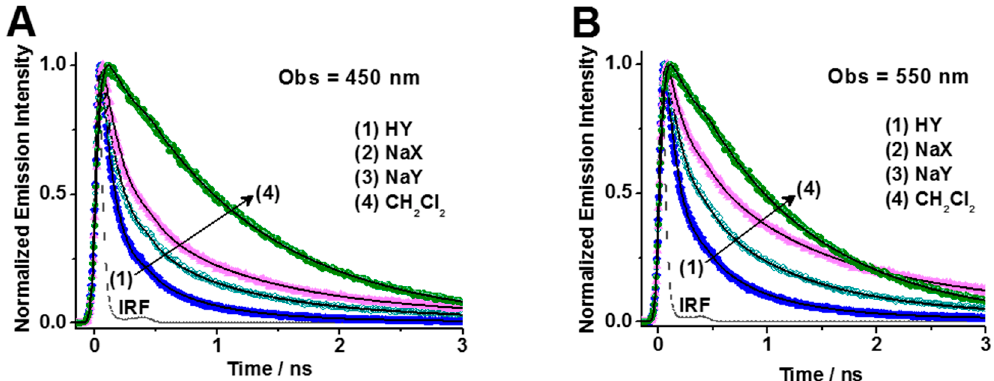
Figure 5. Normalized (to the maximum of intensity) magic-angle emission decays of DCM in presence of HY, NaX, and NaY zeolites (initial dye concentration: 1 × 10 − 4 M) in dichloromethane suspensions and comparison with the free dye in dichloromethane solution upon excitation at 371 nm and observing at ( A ) 450 or ( B ) 550 nm for the three complexes. The observation wavelength for the free dye is, in both cases, 600 nm. The solid lines are from the best multi-exponential fits to the experimental data. IRF is ~70 ps.